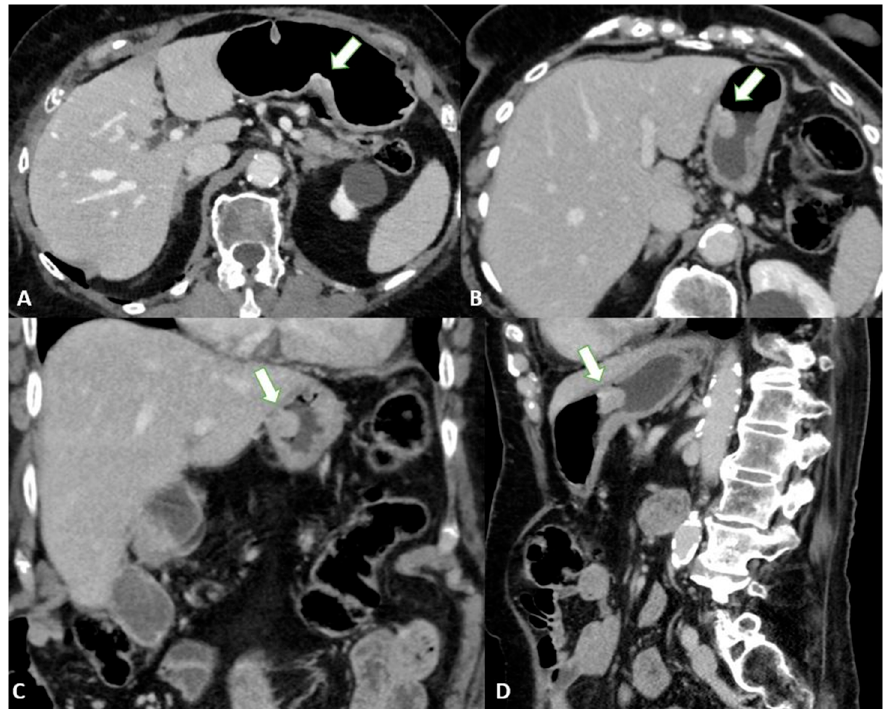
Figure 1. T2 gastric cancer in a 67-year-old-female patient. ( A ) Axial 2D image in the portal venous phase showing enhanced wall thickening in the lesser curvature side of the low body of the stomach (white arrow). T2 gastric cancer in a 66-year-old-male patient. ( B ) Axial 2D image ( C ) Coronal 2D image and ( D ) Sagittal 2D image showing enhanced wall thickening (white arrow) in the lesser curvature side of the middle body of the stomach. In both the patients, the tumor invades the muscularis propria layer.